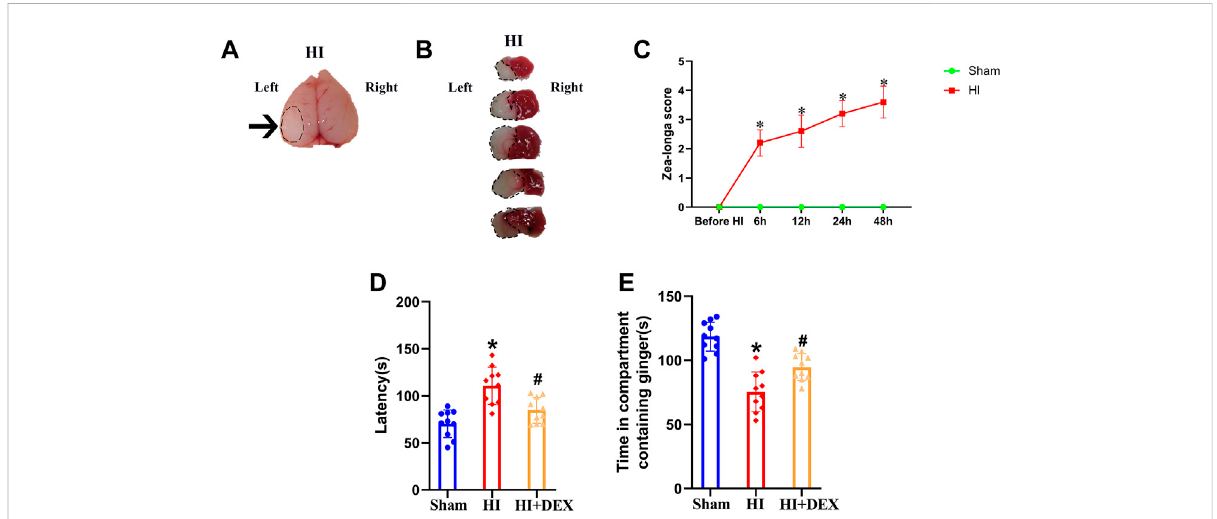
FIGURE 2 DEX alleviated long-term olfactory cognitive dysfunction in neonatal rats caused by HIBD. (A) Brain imaging in the HI group; the black arrow represents the white cerebral infarct focus of the ipsilateral injured hemisphere. (B) TTC staining of the brain from rats in the HI group. The black circulardottedlinesdepicttheinfarctionzone. (C) LinechartshowingZea-longascoreintheshamandHIgroupsbeforeHI,andat6,12,24and48 h post-insult.DataindicatethatthescoresintheHIgroupweresigni fi cantlyhigherthanthoseintheshamgroup.Theburiedfoodtest (D) showed thatthelatencyto fi ndhiddenfeedwithin5 minintheHIgroupwassigni fi cantlylongerthanthatintheshamgroup.Thelongerlatencyto fi ndhidden feed caused by HIBD was partially reversed by DEX. The olfactory memory test (E) showed that the time that rats spent in the compartment containing ginger essential oil was signi fi cantly decreased in the HI group when compared with the sham group, but the olfactory memory impairment induced by HIBD was partially reversed by DEX. HIBD, Hypoxic-ischemic brain damage; HI, Hypoxia-ischemia; TTC, Triphenyl tetrazolium chloride; DEX, Dexmedetomidine; h, hour (s); min, minute (s). Data are expressed as the mean ± SD ( n = 10 per group). * p < 0.05 vs. the sham